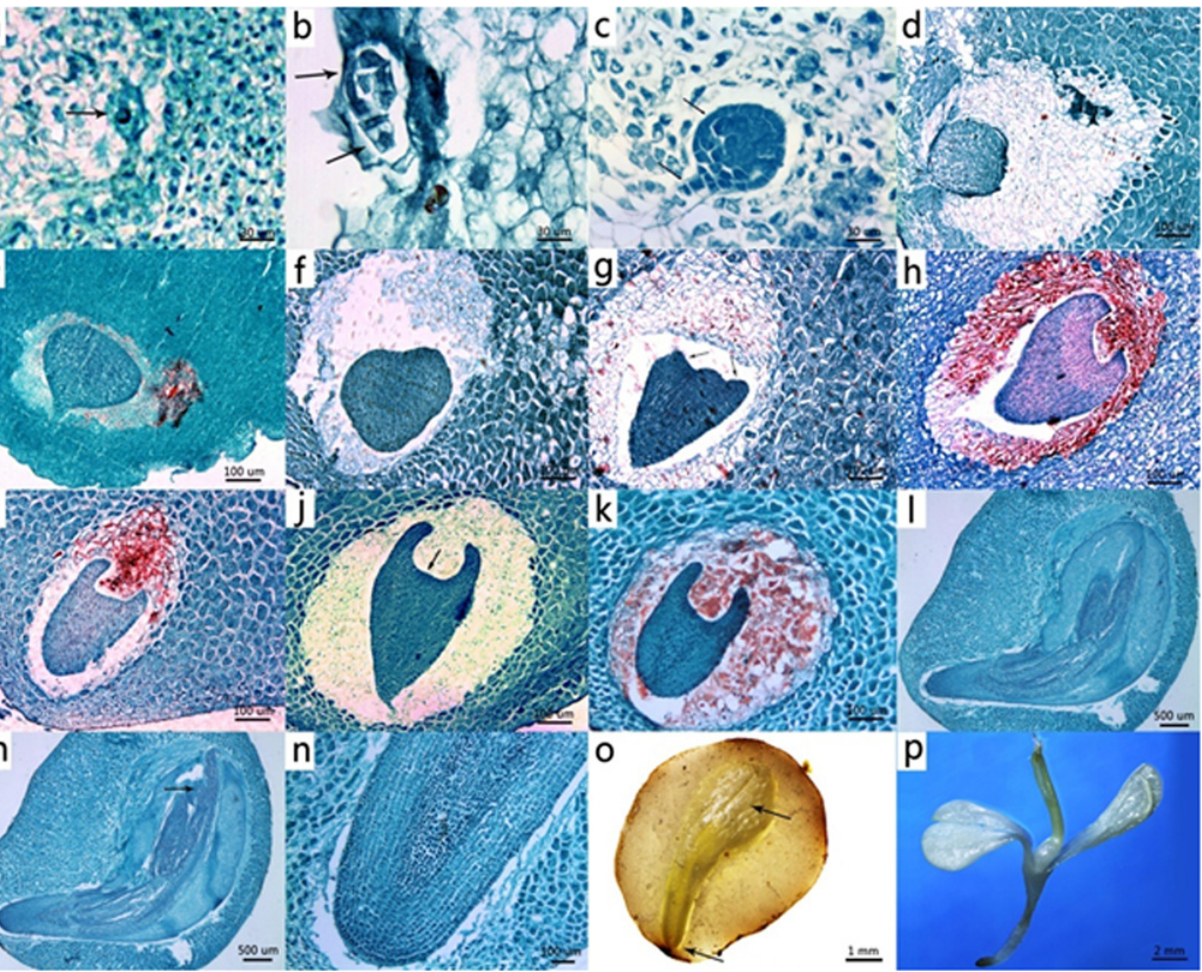
Fig 1. Development and stratification of American ginseng seeds. (a) Zygotic embryo at 7 days after pollination (DAP). (b) Embryo with 16 cells. (c) Globular stage embryo at 28 DAP. (d-e) Late globular or triangular stage embryo at 38 DAP. (f-g) Late triangular or early heart stage embryo at 48 DAP. (h-i) Early torpedo stage embryo at 58 DAP. (j) Late torpedo stage embryo at 63 – 77 DAP indicated shoot apical meristem. (k) Warm stratified seeds indicated no split; (l-o) split seeds after warm stratification. (p) Seedling after cold stratification.